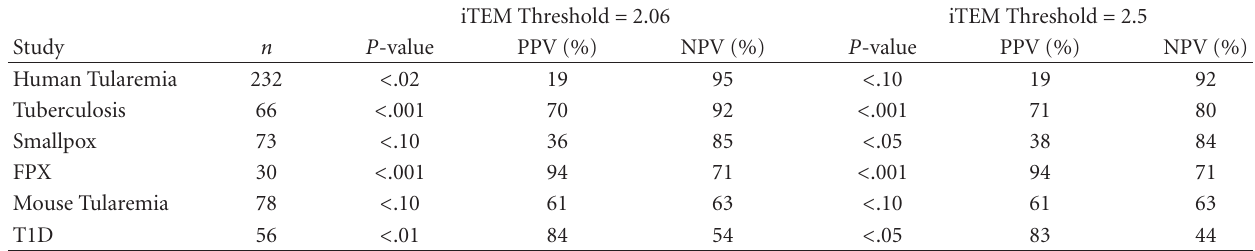
Table 2: A summary of the results using the threshold model for iTEM’s association with immunogenicity listed in descending NPV for an iTEM threshold of